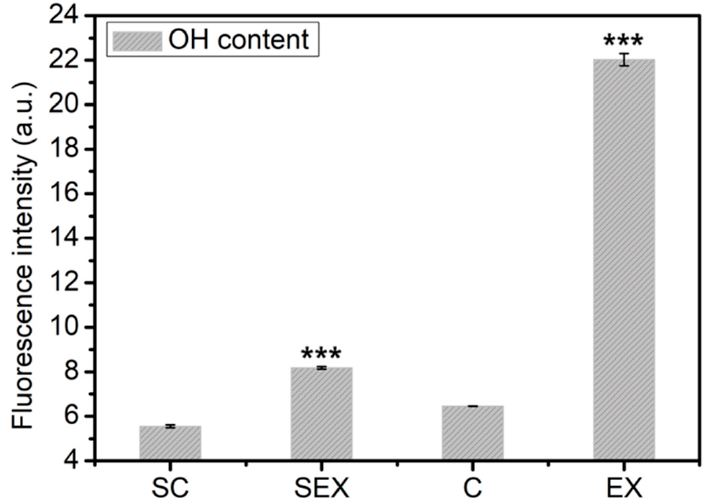
Figure 6. Fluorescence intensity of extracellular · OH generated at 4 h. C and SC are control groups under open air and shading of M. aeruginosa , and EX and SEX experimental groups under open air and shading of M. aeruginosa . Statistical significance (determined by paired t -test) is shown by *** = p < 0.0001, when compared to control (0).